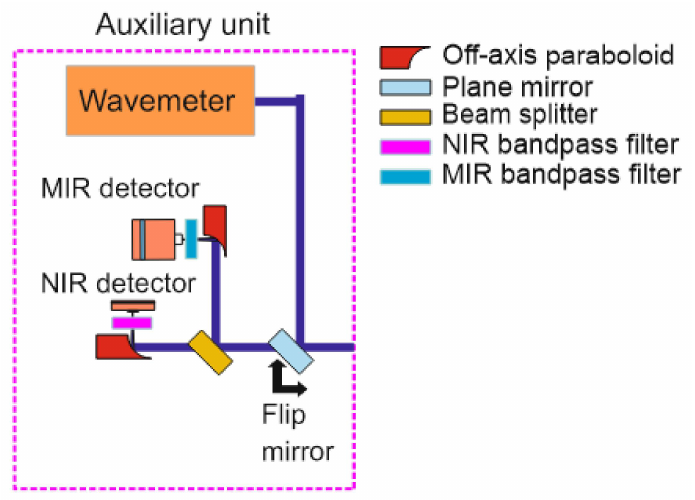
Figure 7. Schematics of the auxiliary